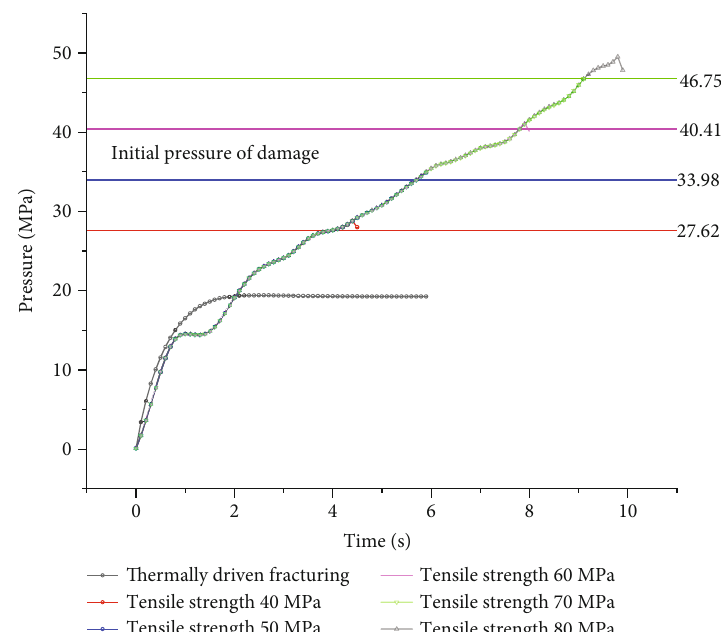
Figure 19: Pressure variation curves of thermally driven fracturing and hydraulic fracturing for rock tensile strength greater than 40.1MPa.